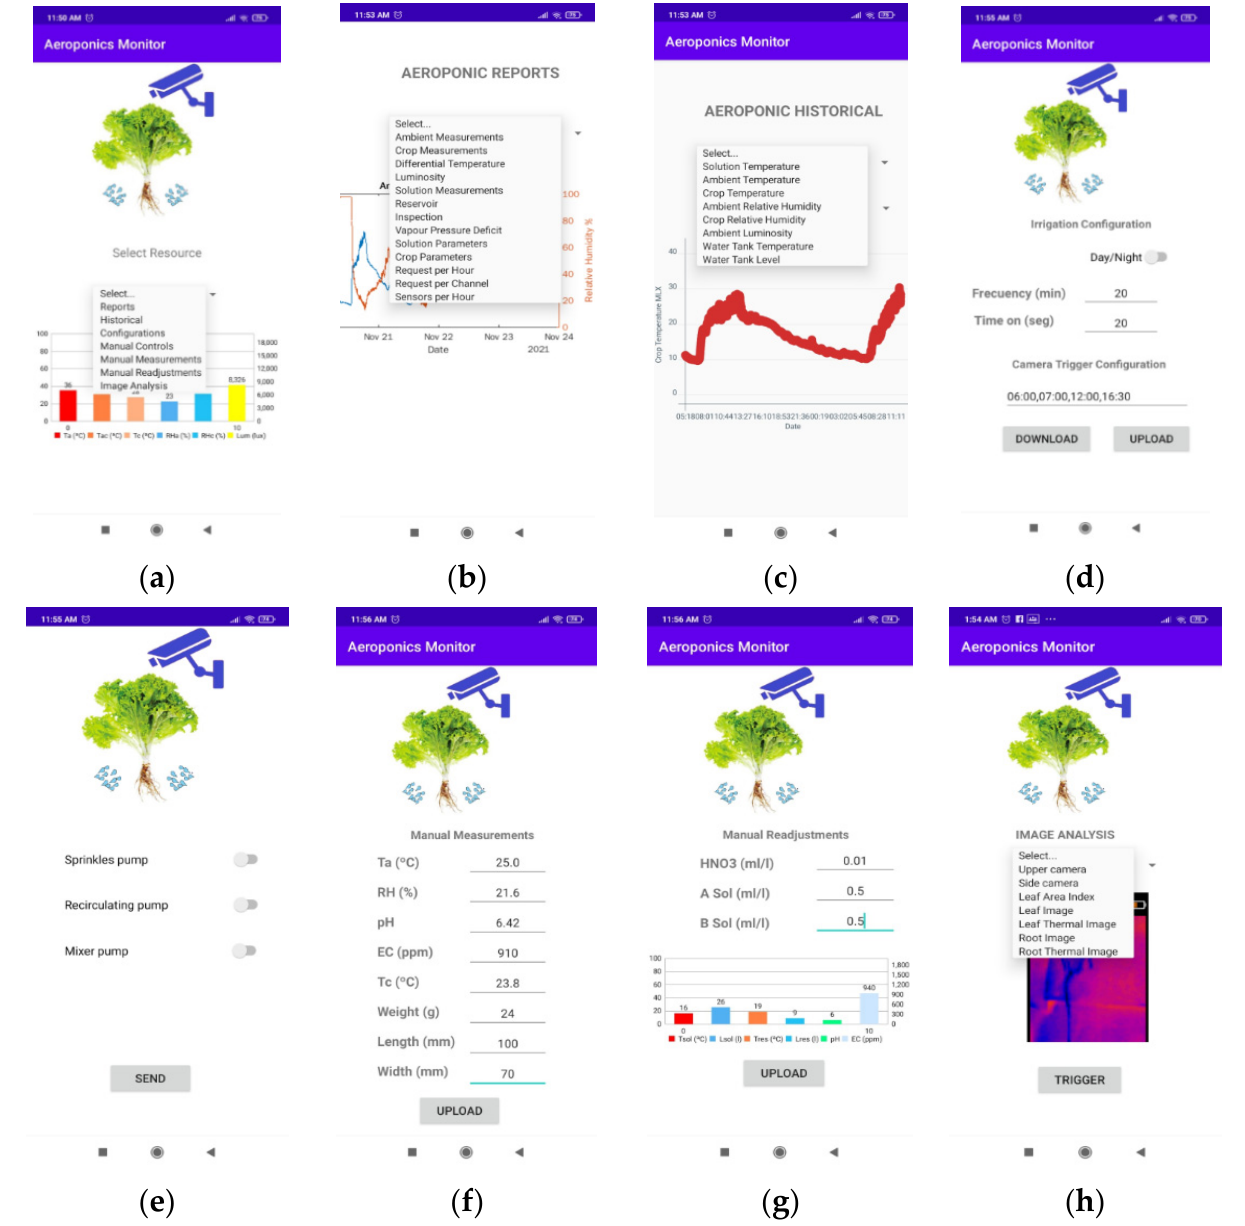
Figure 4. Windows of Aeroponics Monitor. ( a ) Initial window; ( b ) report window; ( c ) record window; ( d ) settings window; ( e ) manual controls window; ( f ) manual measurements window; ( g ) manual readjust window; ( h ) image analysis window.